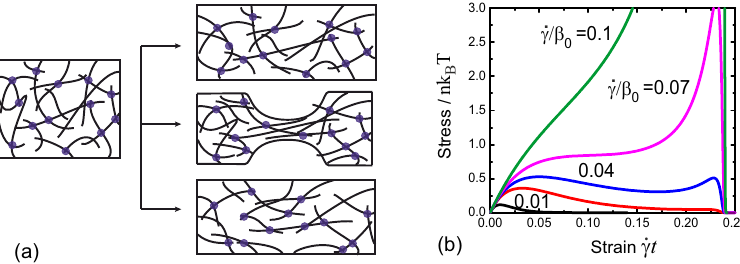
Figure 16. ( a ) Sketches of a transient filament network under an uniaxial stretch, behaving (i) elastically; (ii) showing the necking instability; (iii) plastically flowing; ( b ) Stress-strain relationship of a transient network under uniaxial stretch λ = 1 + ˙ γ t with different strain rates. At long times/high deformations, the highly non-linear response of filaments under tension leads to the total breakup of the network. Parameters used here are a = 10 − 3 L (bond characteristic length), c = 0.4 (stiffness) and x 0 = 0.8